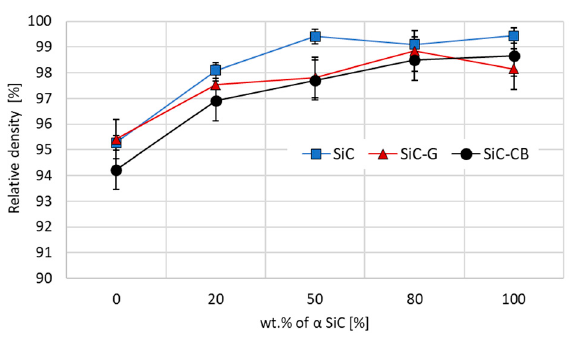
Figure 5. Relative densities of the SiC sinters.